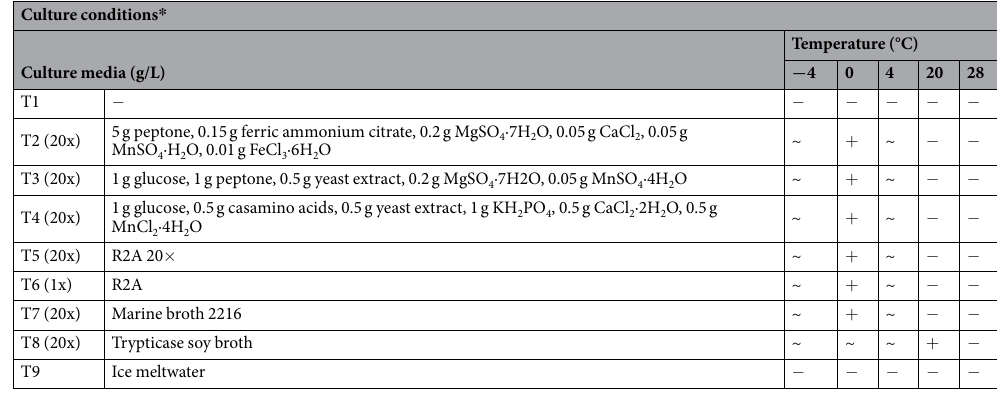
Table 2. Culture conditions for microbial culturomics characterization from the englacial samples of Mount Pond Glacier, Antarctica. * 3 replicates were cultured with each culture condition. T2-T6 107 , T7-T8 98 . Growth was monitored by optical density at 600 nm 12 days. Cultures achieved absorbance values of 0.3 ( + ), 0.1 (~), 0.0 ( −